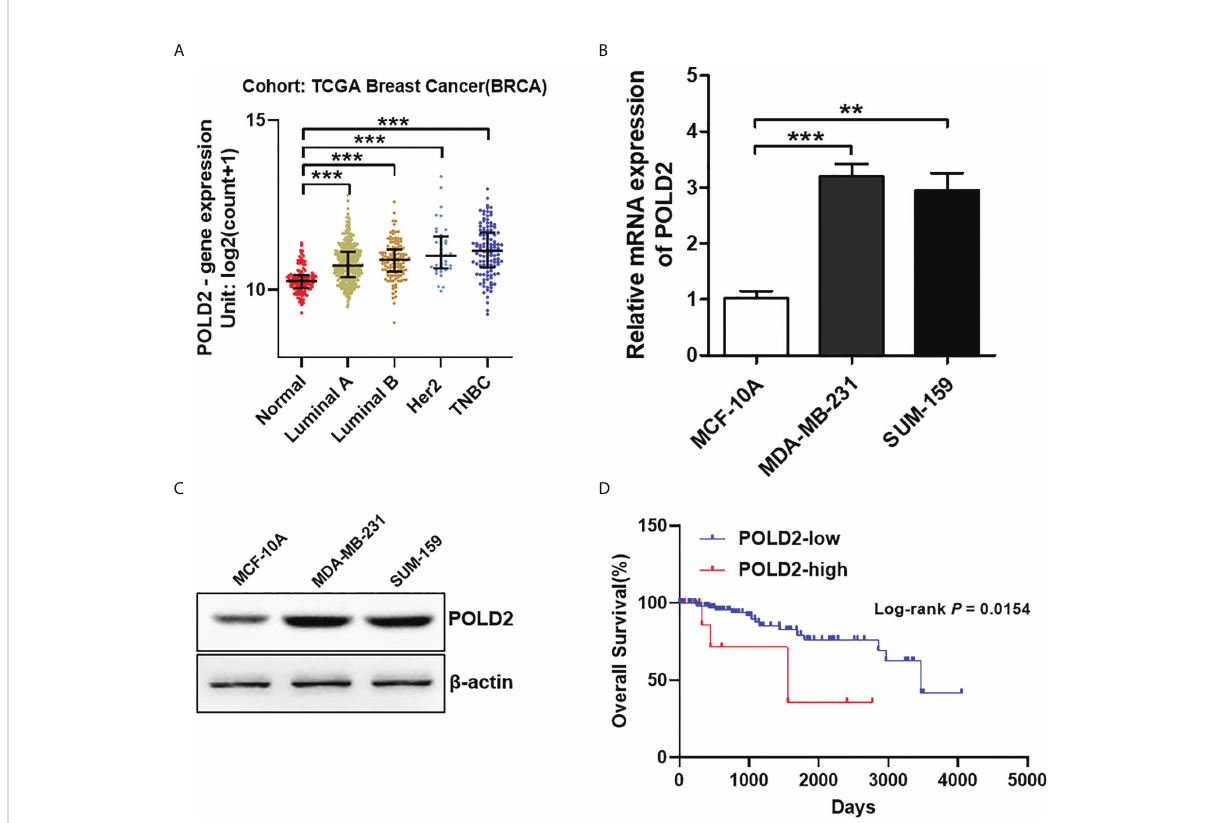
FIGURE 1 POLD2 is highly expressed in TNBC and correlated with the poor prognosis of TNBC patients. (A) The expression of POLD2 in different subtypes of breast cancer (i.e., TNBC, Luminal A, Luminal B, and Her2 positive) tissues and adjacent normal tissues from the TCGA database. *** P < 0.001. (B, C) The mRNA and protein expression of POLD2 in normal breast epithelial cell line MCF-10A and TNBC cell lines MDA-MB-231 and SUM- 159. *** P < 0.001, ** P < 0.01. (D) Kaplan – Meier curves show that patients with high expression of POLD2 in their TNBC tumors have shorter overall survival than patients with low expression from the TCGA database. P = 0.0154 by log-rank test. Data represent the mean ± SD of three independent